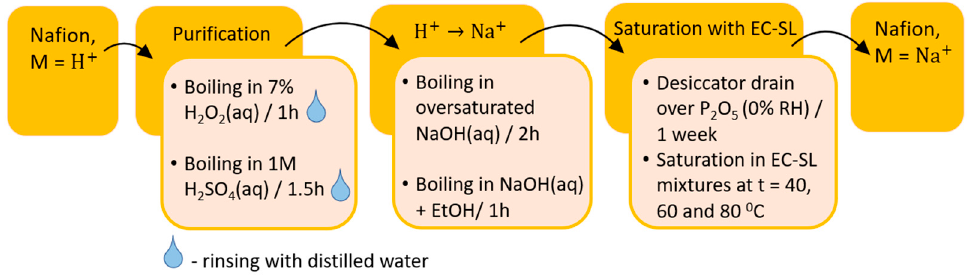
Figure 2. Scheme for obtaining the sodium form of Nafion membranes.